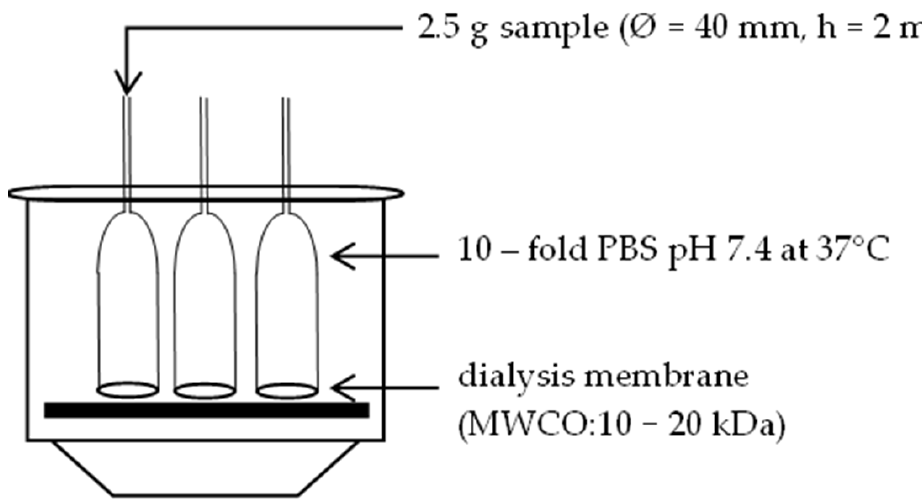
Figure A1. The setup for the gel wafer preparation. Upside down glass funnels were covered with dialysis membranes, filled with 2.5 g of sample, and solidified in a desiccator used as a water bath. The water bath was filled with PBS at pH 7.4 with at least 10x the volume of the gel being solidified. The buffer was heated to 37 °C. The gelling process took 48 h and the buffer was exchanged after 24 h.